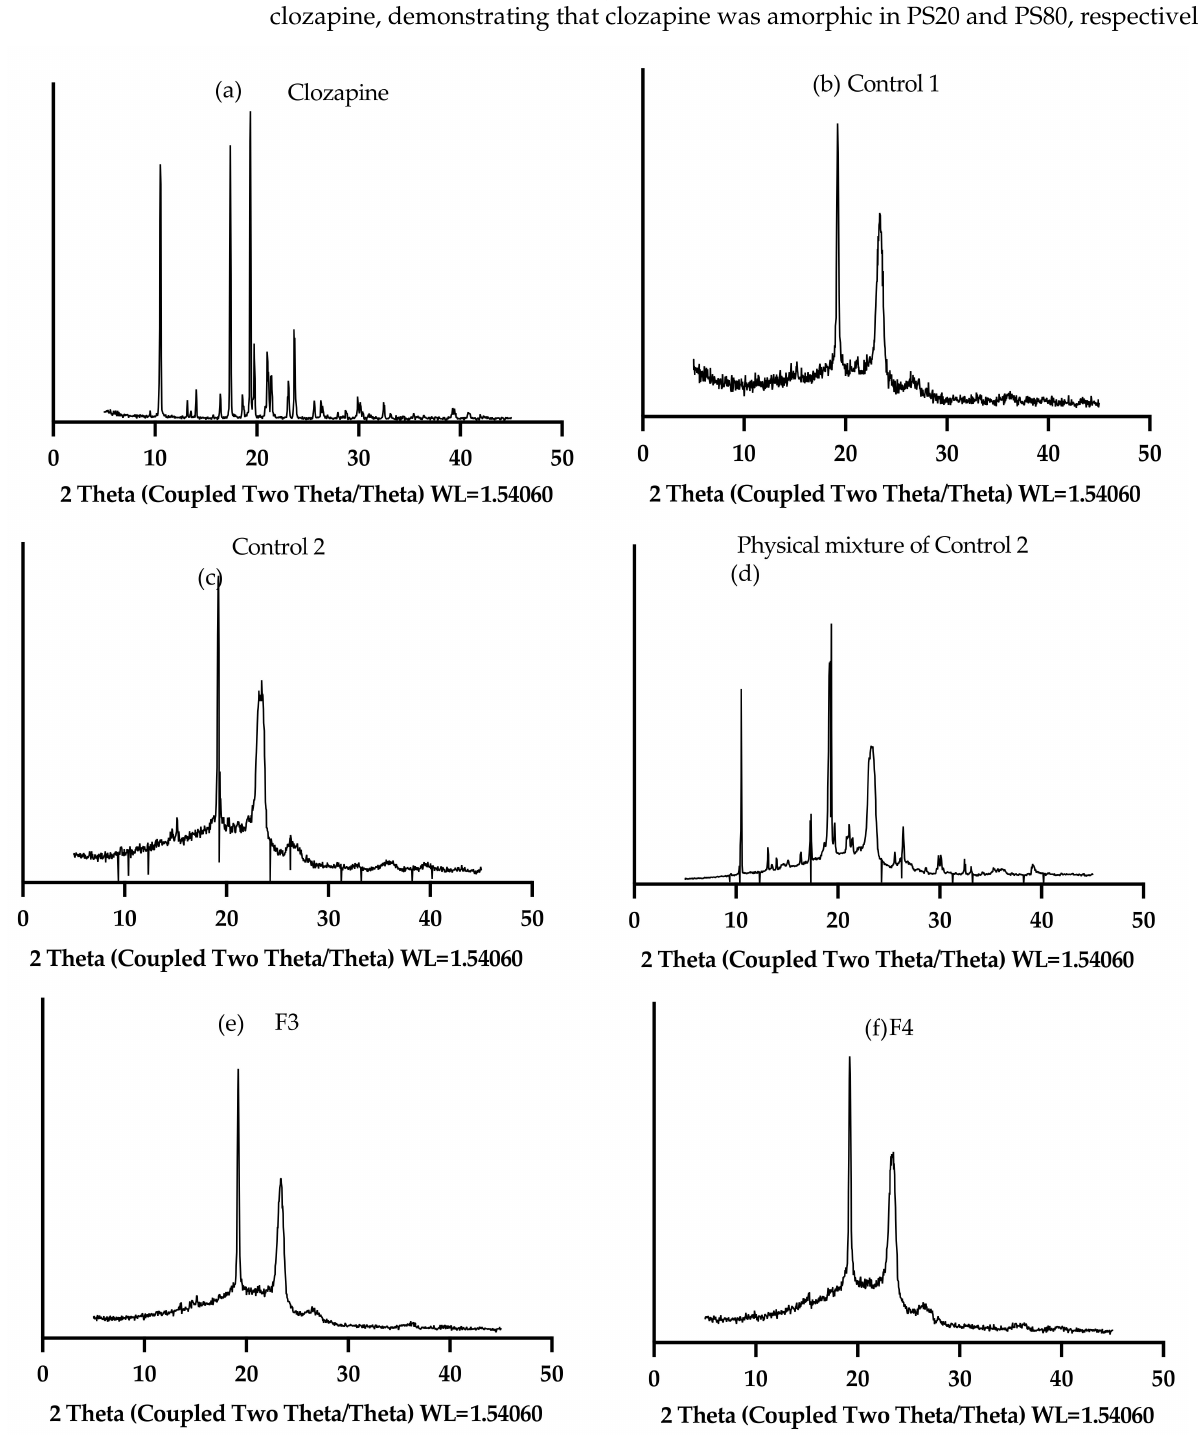
Figure 13. XRD patterns of clozapine, Control 1, Control 2, physical mixture of Control 2, F3 and